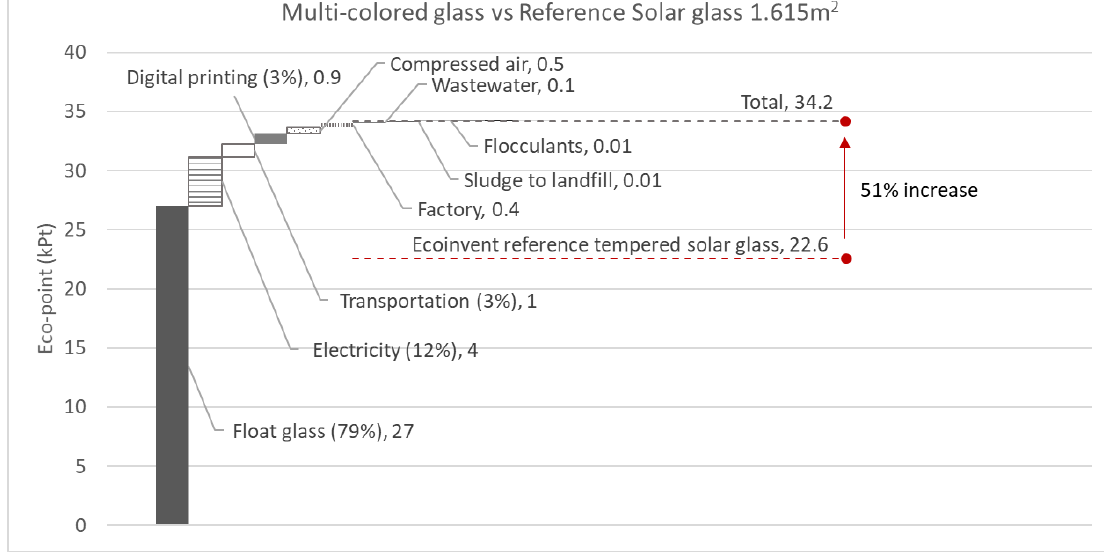
Figure 6. Per-process and component breakdown of eco-points for 1.615 m 2 of multi-coloured glass for a PV laminate modelled in this study. The total (34.2 kPt) is 51% higher than that of tempered solar glass (22.6 kPt) in Ecoinvent. The printing step to obtain the multi-coloured glass only contributes 3% to the total